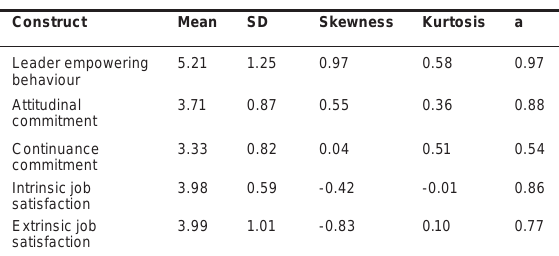
Research procedure